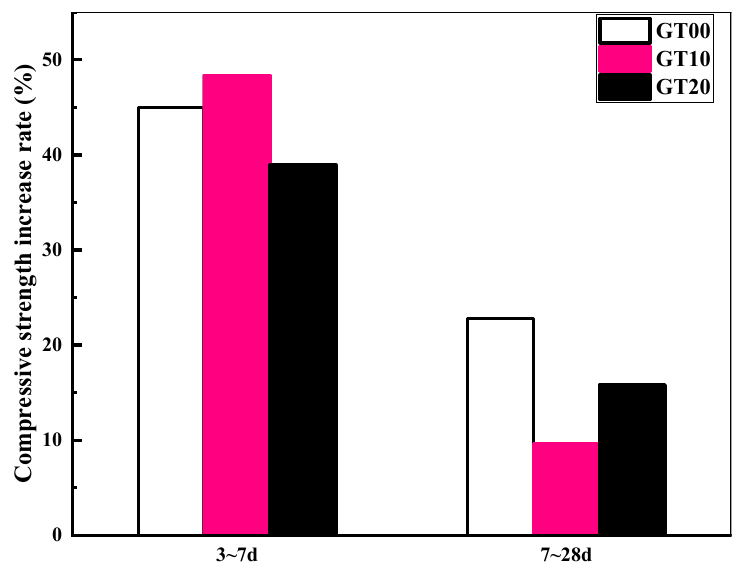
Figure 11. Compressive strength of specimens with different substitution rates.